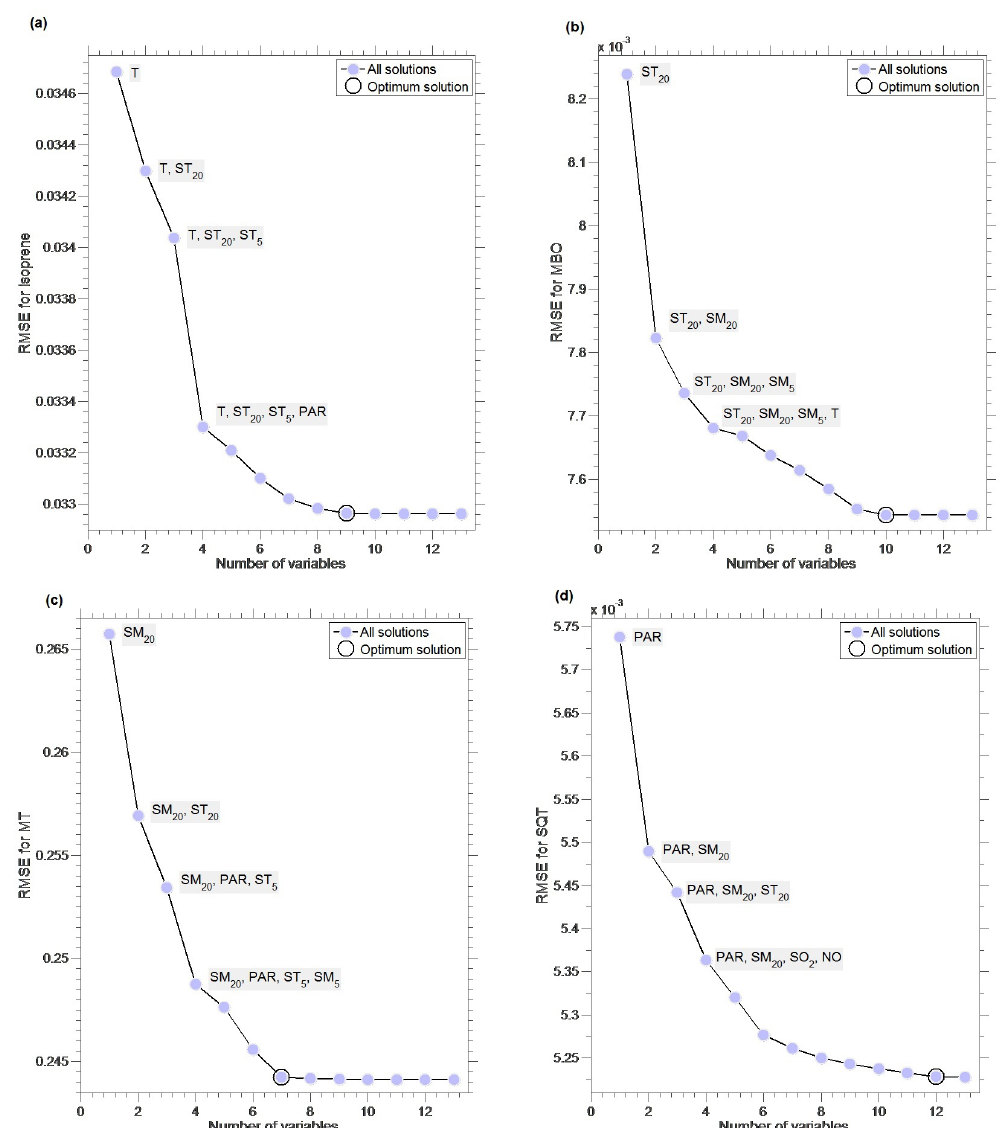
Figure 7. The optimum combination of independent variables to include in a MLR equation to calculate the dependant variable, i.e. BVOC concentrations. The root mean square error (RMSE) difference between the calculated and measured concentrations indicated that the in- clusion of (a) 9 parameters for isoprene, (b) 10 parameters for MBO, (c) 7 parameters for MT, and (d) 12 parameters for SQT in the MLR solution was the